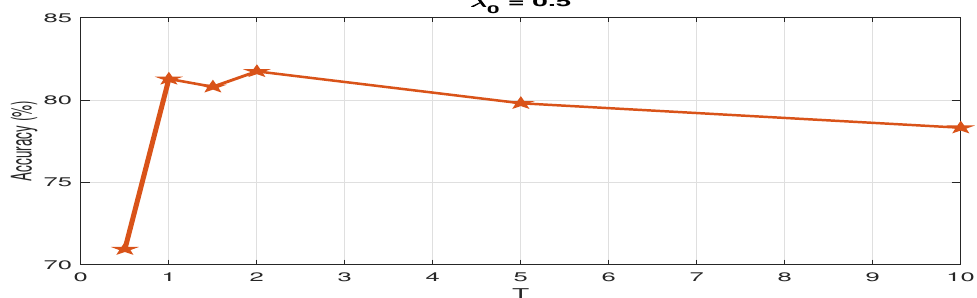
Figure 7. Comparison of accuracies of various values of temperature parameter T for λ o = 0.5 using the Adam optimizer on the LCF-15